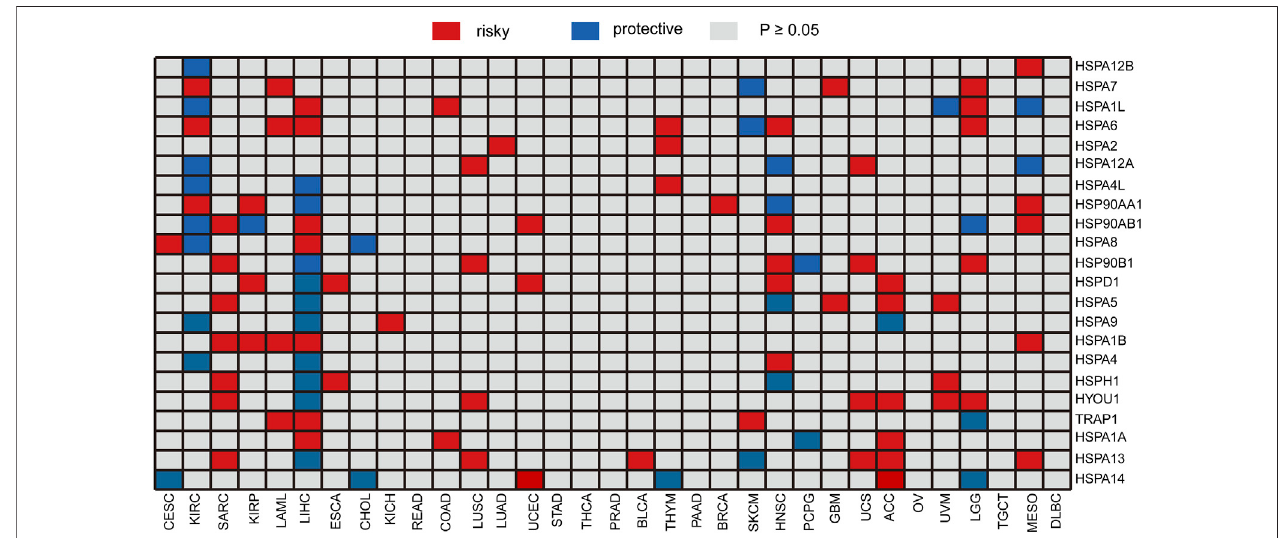
FIGURE 5 | Heatmap of the relationship between individual HSP expression and overall survival. Red represents a worse prognosis, and blue represents a better prognosis. HSP, heat shock protein.